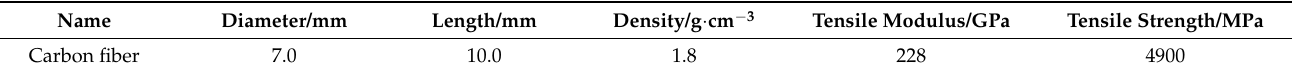
Table 3. Physical properties of CF.